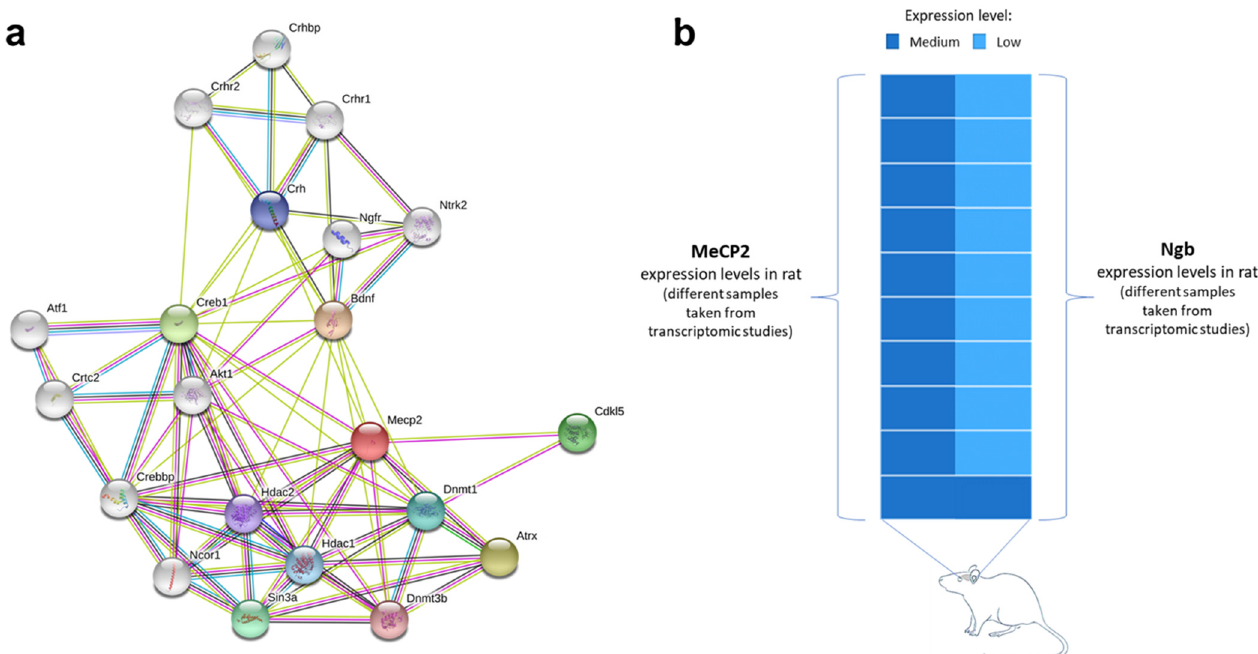
Figure 6. MeCP2 interactors’ analysis. ( a ) The network of the MeCP2 interactors obtained by a queryin STRING v 11.0 revealed that no direct association between this protein and neuroglobin exists. Furthermore, the extended form of this matrix (shown in this figure) depicts that these two proteins do not share common interaction nodes (the important nodes have various colors, except grey) ( b ) A total of 10 different rat brain samples depict the gene expression contrast between MeCP2 and Ngb in rat cerebral tissue; in terms of specific expression levels, values of TPM > 10 were considered as ‘Medium’, with numbers ranging from 17 to27 TPM for MeCP2 expression and from 2 to 12 TPM for Ngb. Each tab represents a different sample analyzed in a transcriptomic study; these 10 sample sources were the only ones available at the time of the interrogation of Ensembl Gene Expression database).